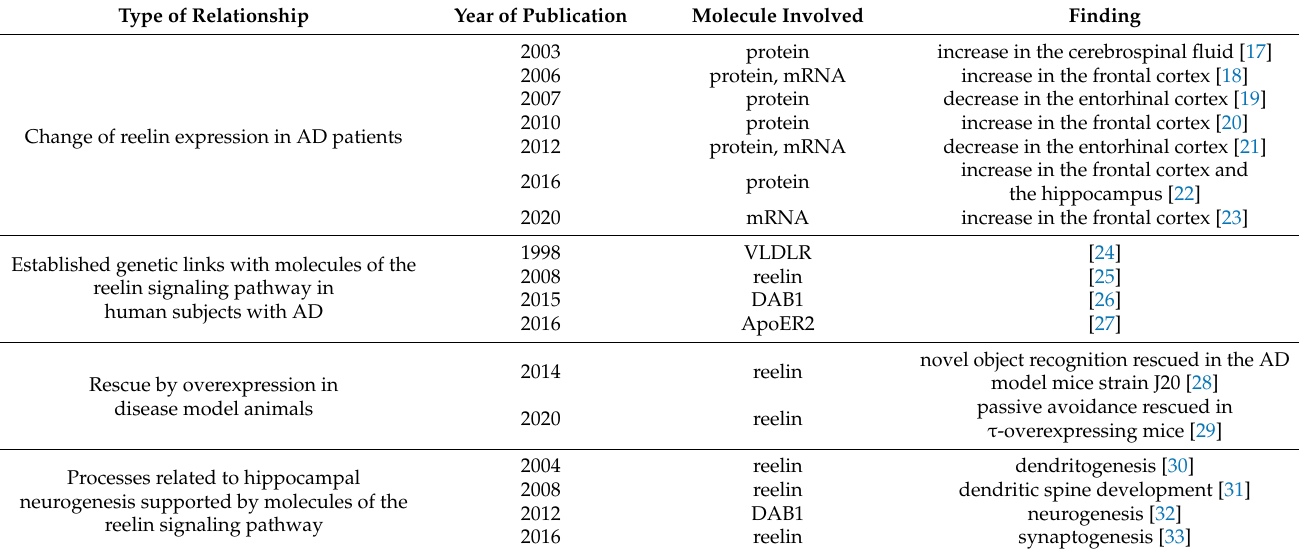
Table 1. Summary of relevant previous research on the relationship between reelin, AD, and hip- pocampal